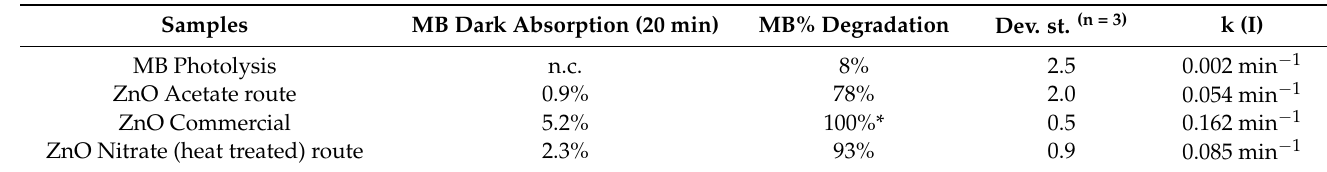
Table 2. Photocatalytic results expressed as methylene blue (MB) percentage degradation after 50 min and 1st order kinetic